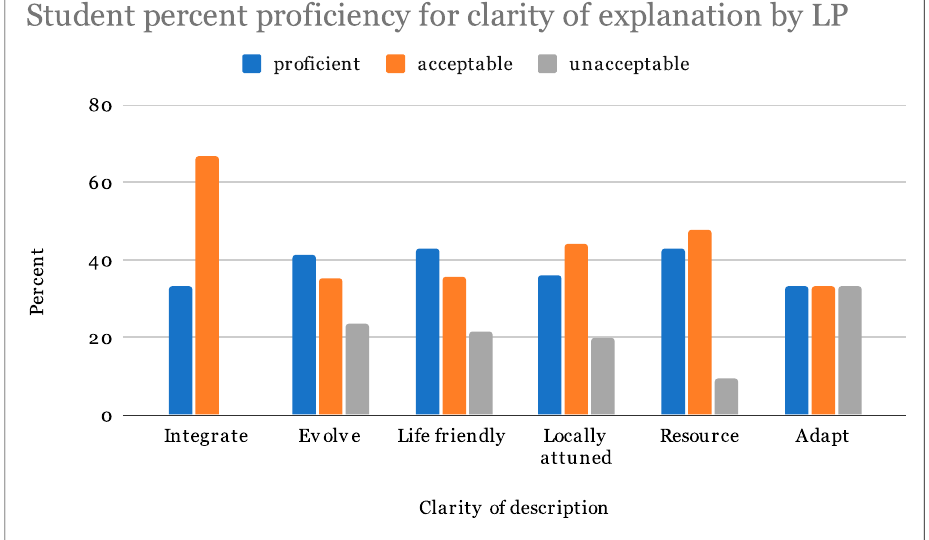
Figure 9. Student proficiency for clarity of explanation by LP. Table 4. Summary table single factor ANOVA for followed directions.